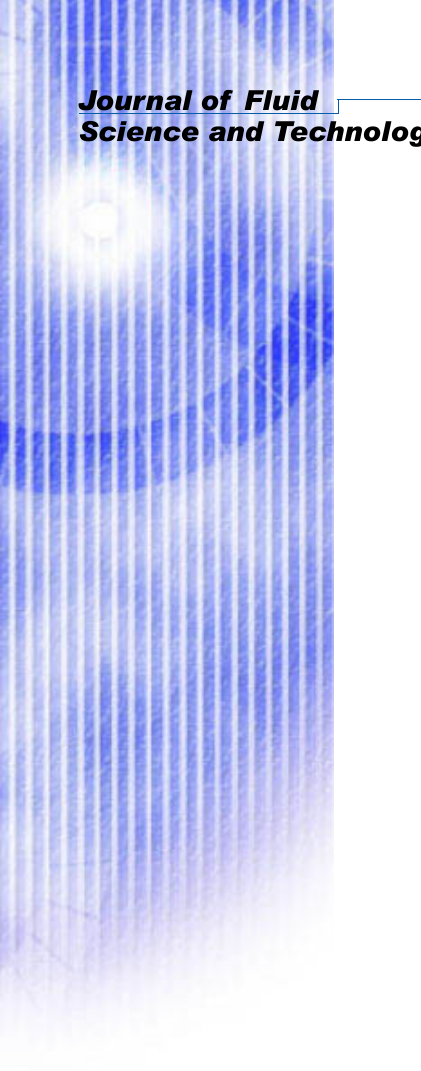
Fig. 16 Log RR (reduction rate) vs cavitation number for E.